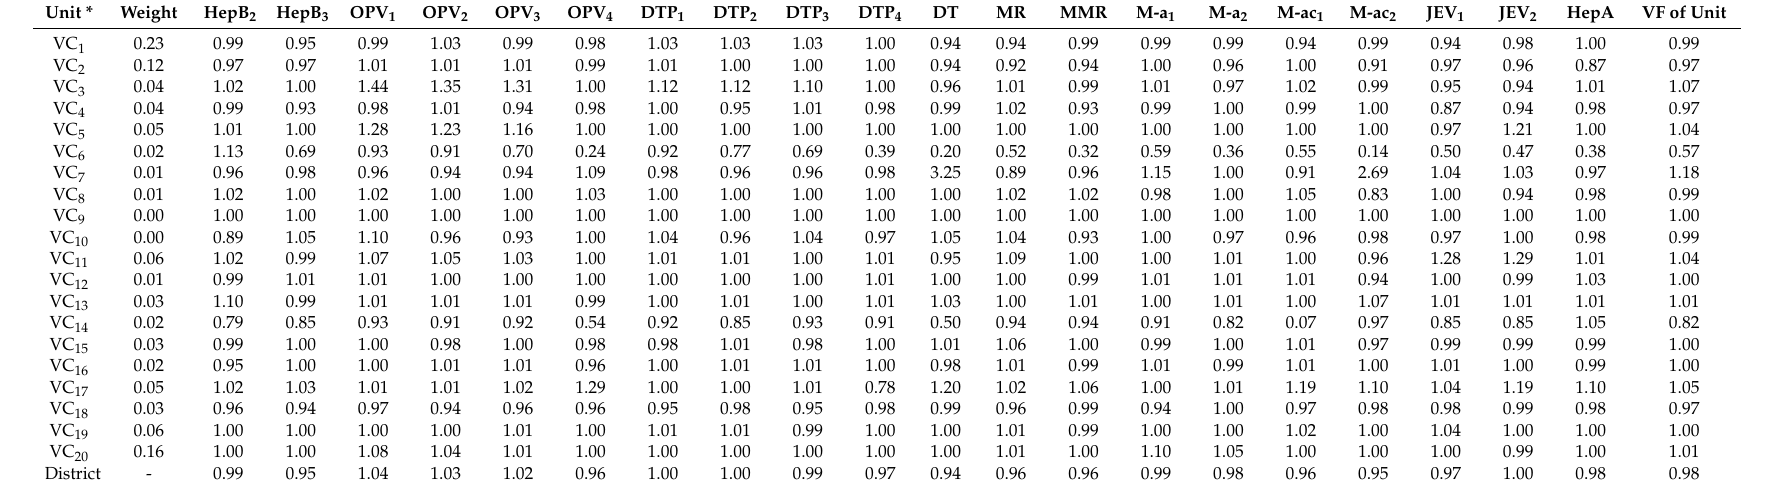
Table 1. District and vaccination clinic VFs from audit of immunization data quality in Shangyu District,